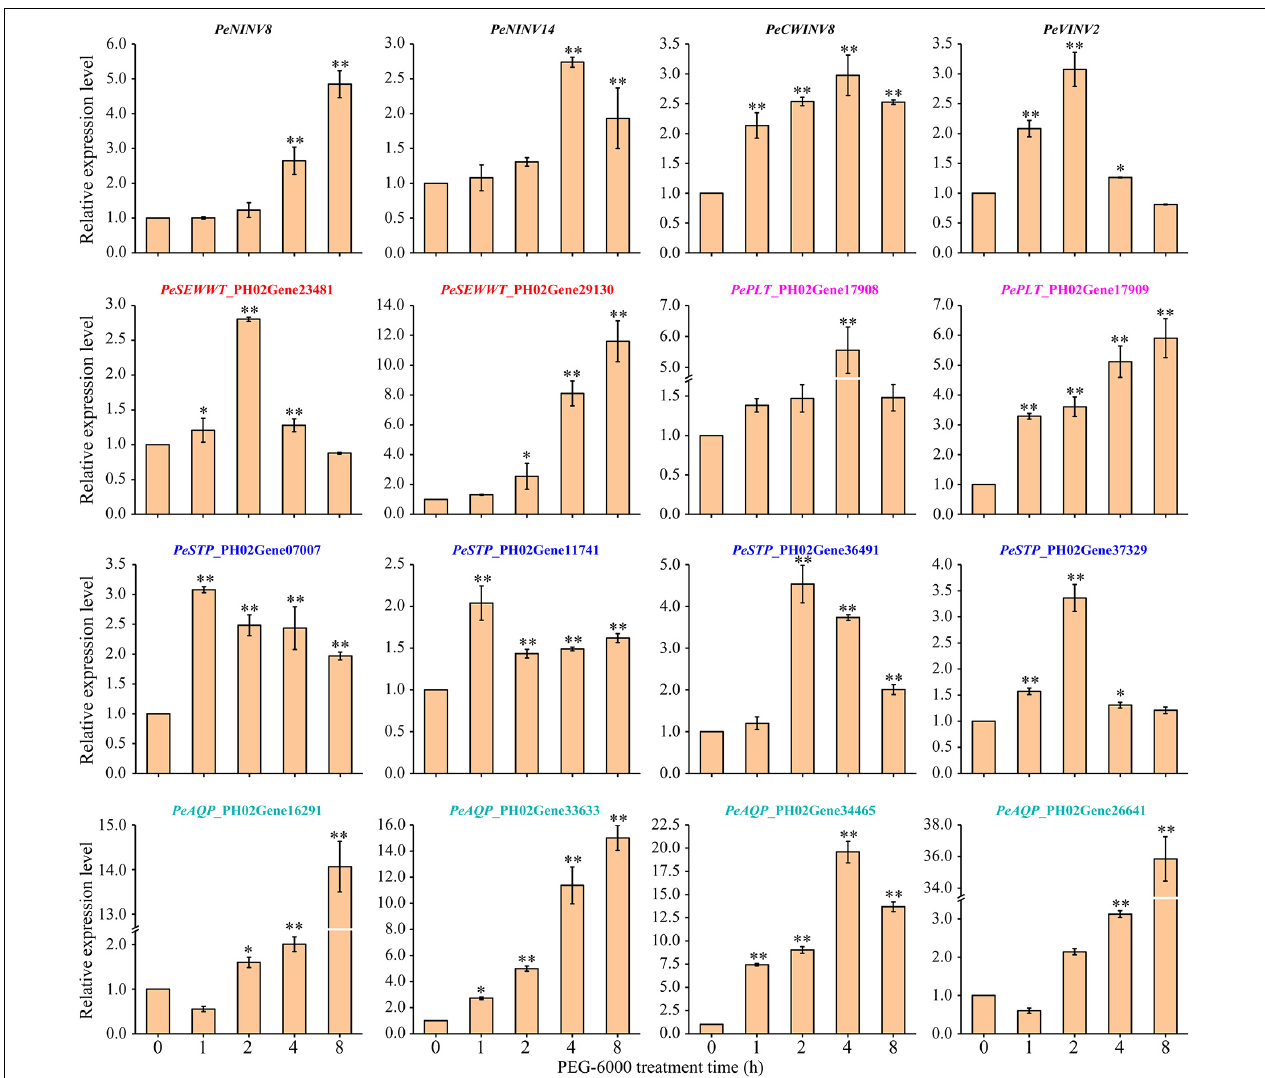
FIGURE 7 | Expression patterns of 4 PeINV s and 12 SWTG s of moso bamboo leaves under drought stress. Fold-change values were used PeTIP41 as internal controls with three technical replicates for each of three biological replicates in the qRT-PCR. The results are expressed as ± SD. The single and double asterisks indicate significant differences at 0.05 and 0.01 levels of the gene expression after different treated times according to student’s t